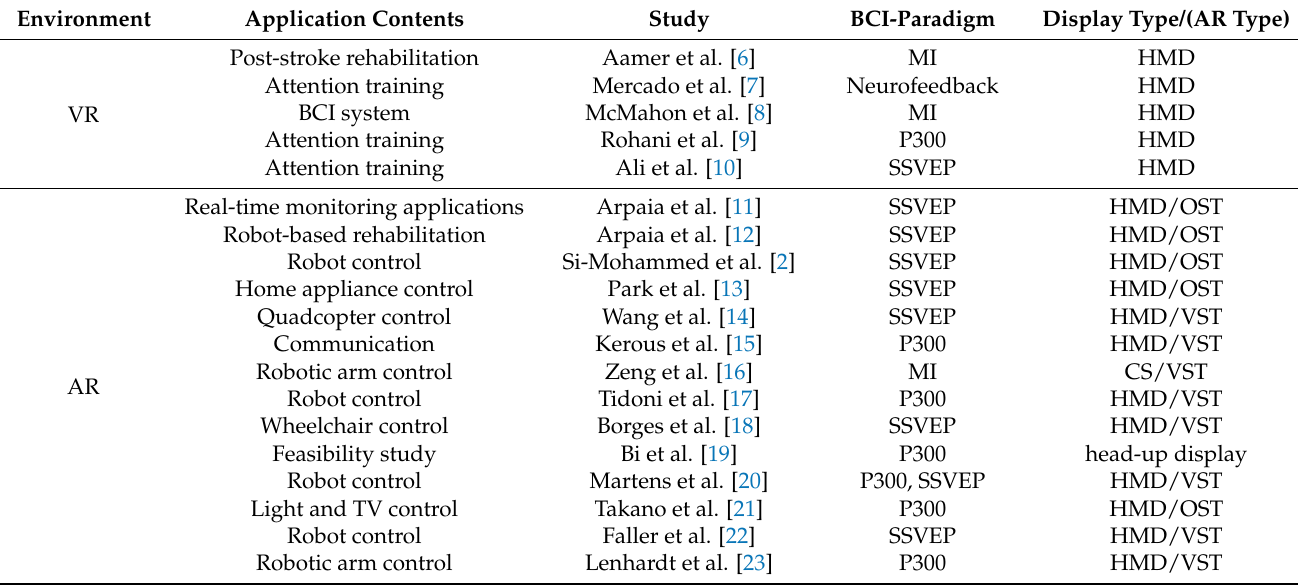
Table 1. Overview of previous VR-BCI and AR-BCI studies. Motor imagery (MI) and steady-state visual-evoked poten- tial